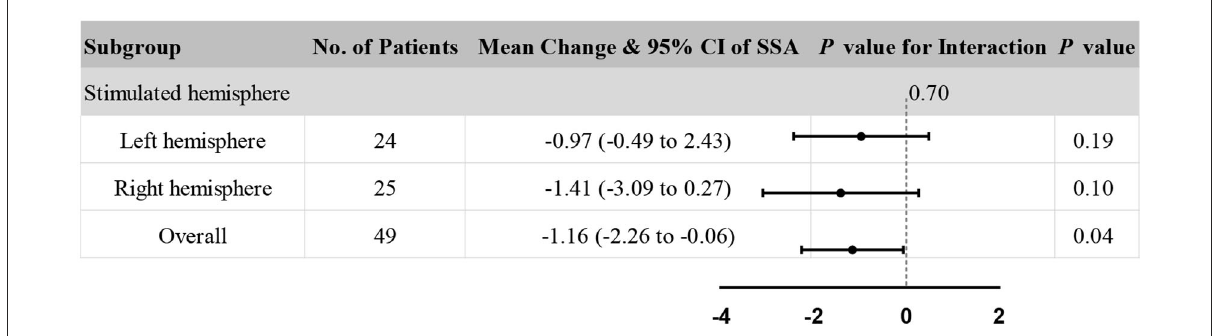
FIGURE5 The subgroup analysis of stimulated hemisphere. P -value is not adjusted by